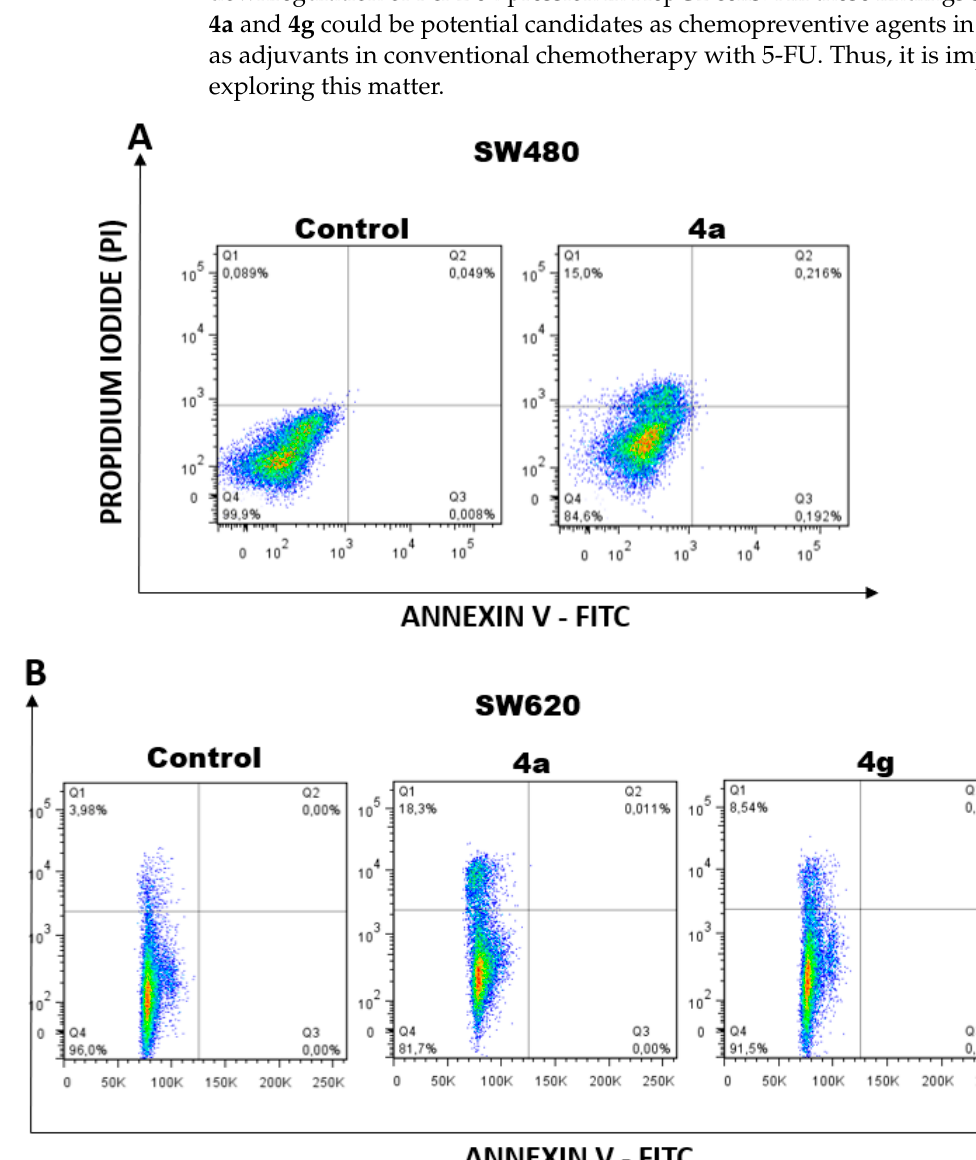
Figure 7. Apoptosis of SW480 ( A ) and SW620 ( B ) after the treatment with hybrids 4a and 4g . Q1 + Q2: Cells that lost membrane integrity (Cells in apoptosis or necroptosis, secondary necrotic cells, death cells, among others); Q3: Viable cells; Q4: Early apoptotic cells. Control cells were treated with DMSO (1%). All experiments were performed in duplicate and gave similar